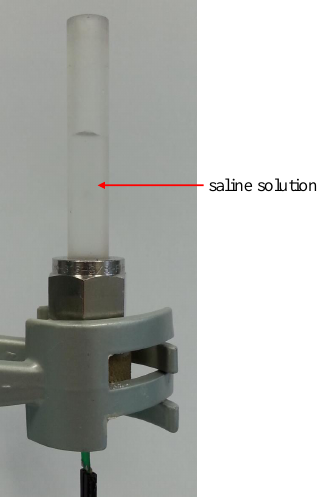
Figure 16. Photo of the housing with the transparent tube for hold- ing the test fluid and creating a well-defined